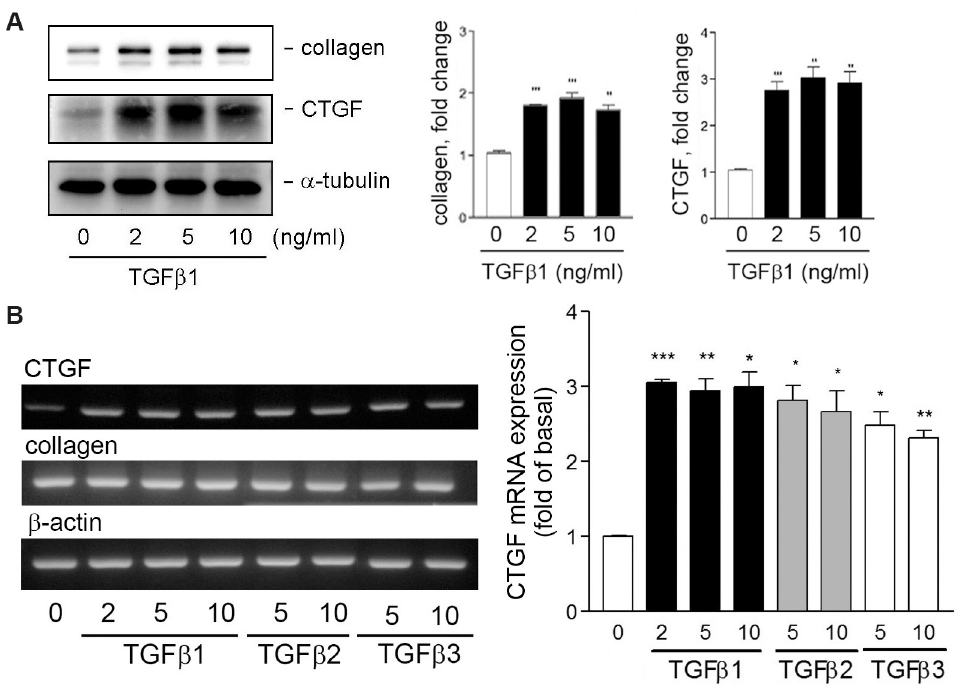
Fig 2. Effects of TGF β isoforms on collagen and CTGF protein and mRNA expression in HESCs. (A) Cells were treated with the indicated concentration of TGF β 1 for 16 h and then analyzed through Western blotting (n = 3). (B) Effect of TGF β isoforms on collagen and CTGF mRNA expression in HESCs. Cells were treated with vehicle or TGF β isoforms (ng/ml) for 4 h. The mRNA expression level of collagen, CTGF, and β -actin was analyzed through RT-PCR and densitometry (n = 2). � P < 0.05, �� P < 0.01, and ��� P < 0.001 versus vehicle treatment only (basal).